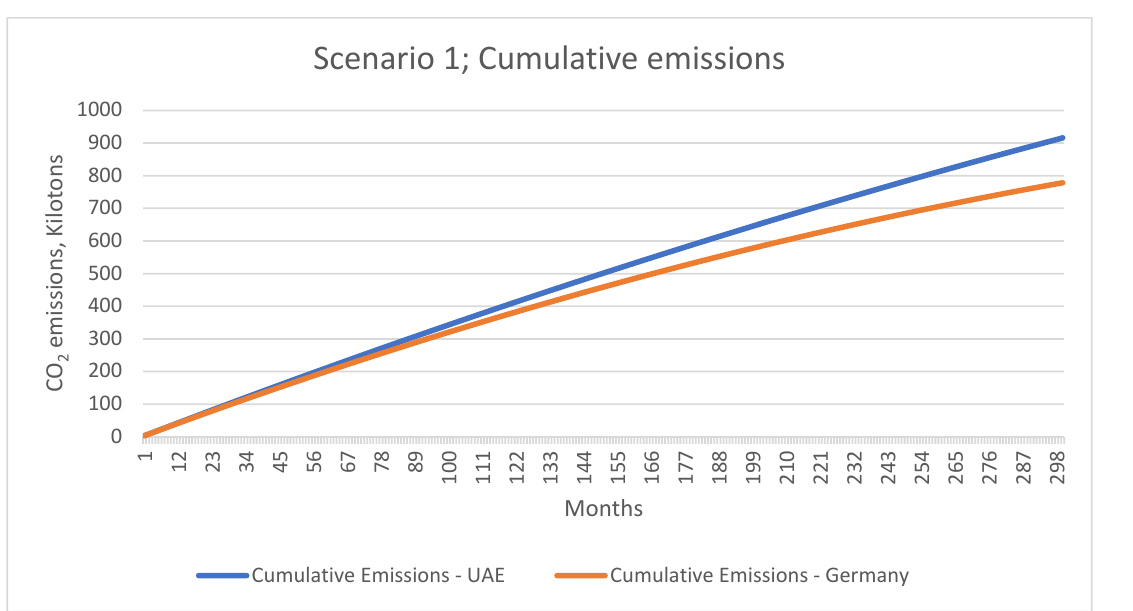
Figure 8. Cumulative expenditure through electricity consumption for UAE and DE under scenario 1.